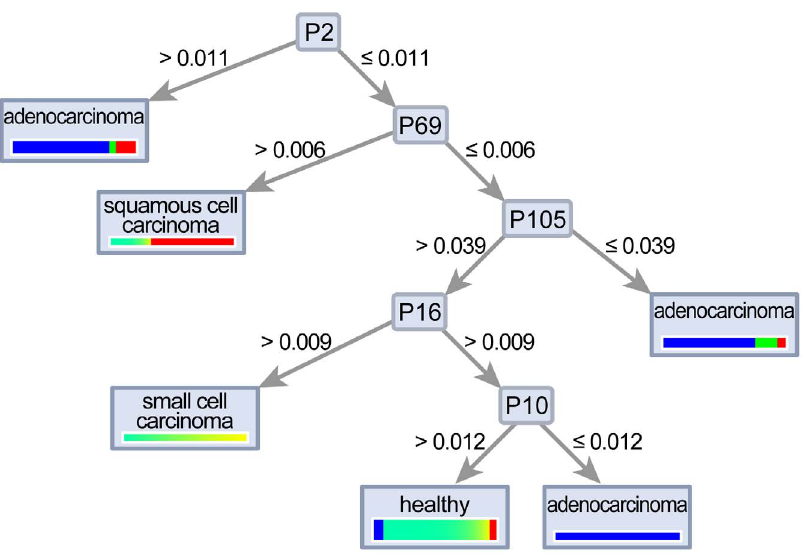
Fig. 6. A decision tree algorithm could separate small cell carcinoma, squamous cell carcinoma and